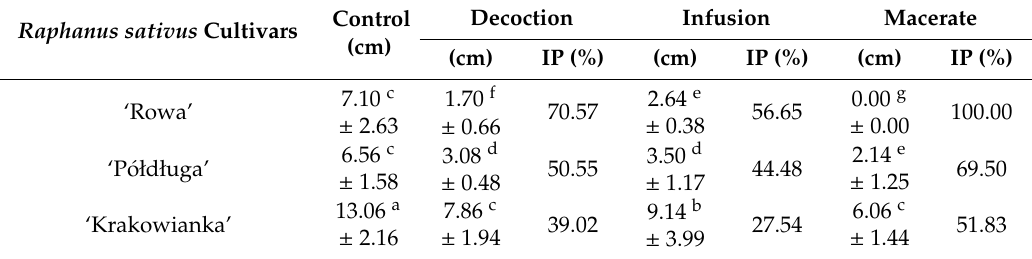
Table 3. Length of Raphanus sativus L. cv. Rowa, P ó łdługa, Krakowianka seedlings, treatment of aqueous extracts from Solidago canadensis L.